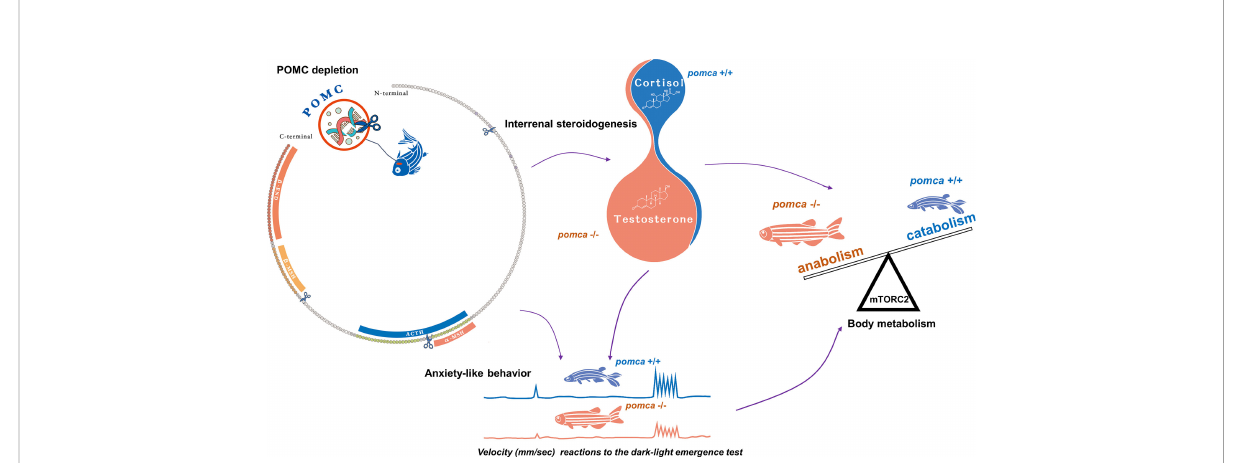
FIGURE 2 Schematic illustration of enhanced growth in pomca knockout zebra fi sh. Depletion of pomca disrupts interrenal steroidogenesis in zebra fi sh (59). Reduced plasma cortisol level and increased testosterone content are observed in pomca mutant zebra fi sh. Reduced cortisol level in POMCa-de fi cient zebra fi sh decreases oxygen consumption and inhibits anxiety-like behavior under dark-light emergence test. Furthermore, Hyperandrogenism is responsible for enhanced somatic growth without increasing adiposity in POMCa-de fi cient zebra fi sh. ACTH, adrenocorticotrophic hormone; b -END, b -endorphin; MSH, melanocyte-stimulating hormone; mTORC2, mammalian target of rapamycin complex 2; POMC,